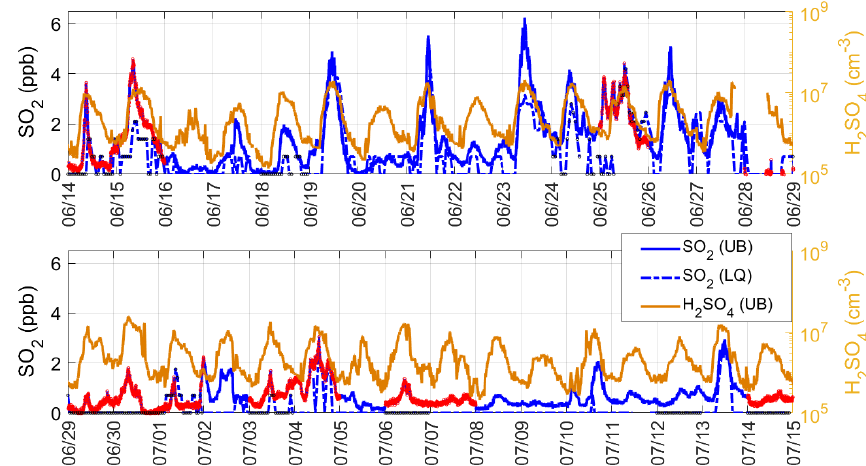
Figure 4. Time series of SO 2 concentration (ppb) at the UB station and Longquan station (LQ) during our observation (left axis) as well as H 2 SO 4 concentration measured at the UB station (right axis). Data below the detection limit are set as zero at both stations. Data on NPF event days were marked in red at the UB station and black at the MT station. The time resolution for SO 2 data was 5min at the UB station and 1h at LQ station, respectively.